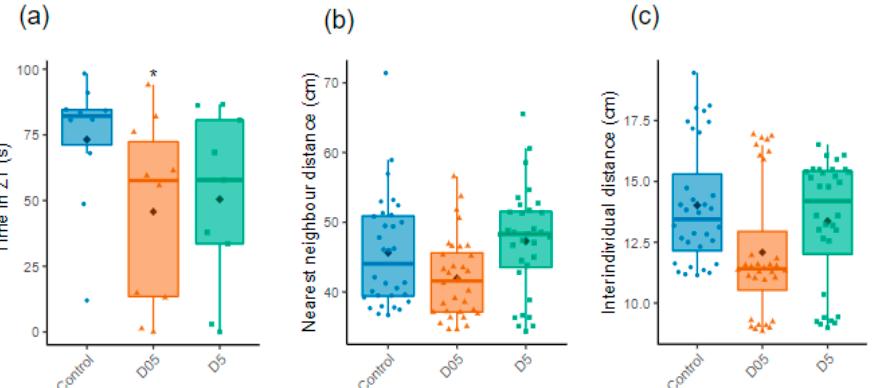
Figure 5. Assessment of individual and group social behavior. ( a ) Time in Z1 evaluated for females during the Social Preference test ( n = 9–10). ( b ) Nearest neighbor distances and ( c ) Inter-individual distances analyzed during the Shoaling test (ShT) ( n = 32). Data are represented by mean (black point), median (horizontal line), ±75th and 25th percentiles and analyzed with Gaussian linear effect model ( a ), Gamma generalized linear mixed models ( b , c ). * p < 0.05.